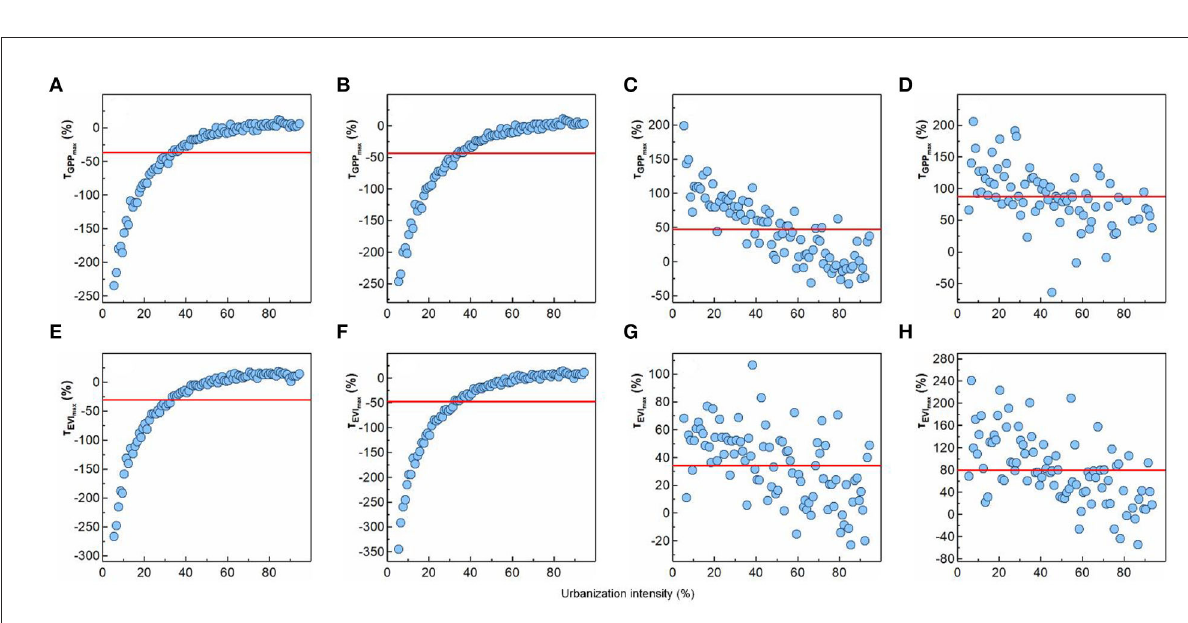
FIGURE5 Growth offset of urbanization on GPP max and EVI max along the urbanization gradient in the whole area (A,E) , forest (B,F) , grassland (C,G) , and wetland (D,H) in 2020. The red line represents the mean values of the growth